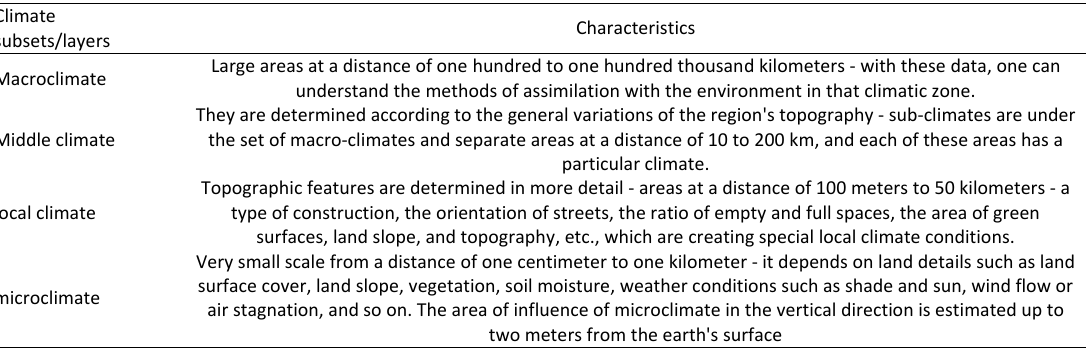
Table 2: Four climate layers (Tahbaz and Djalilian, 2016)